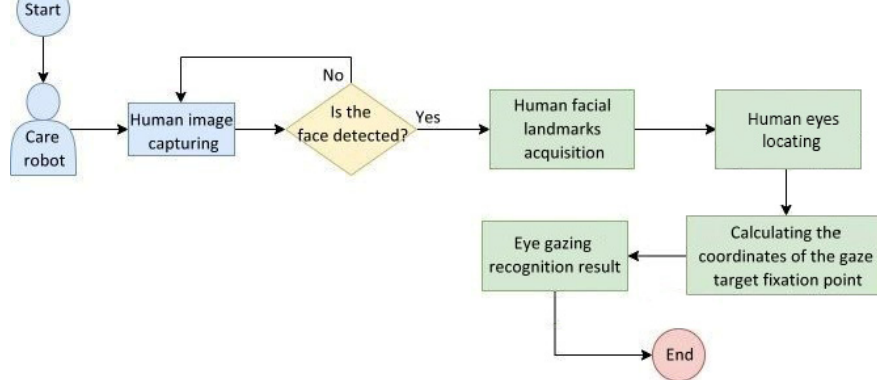
Figure 21. Behavioral flowchart of the eye gazing recognition system embedded in care robots.